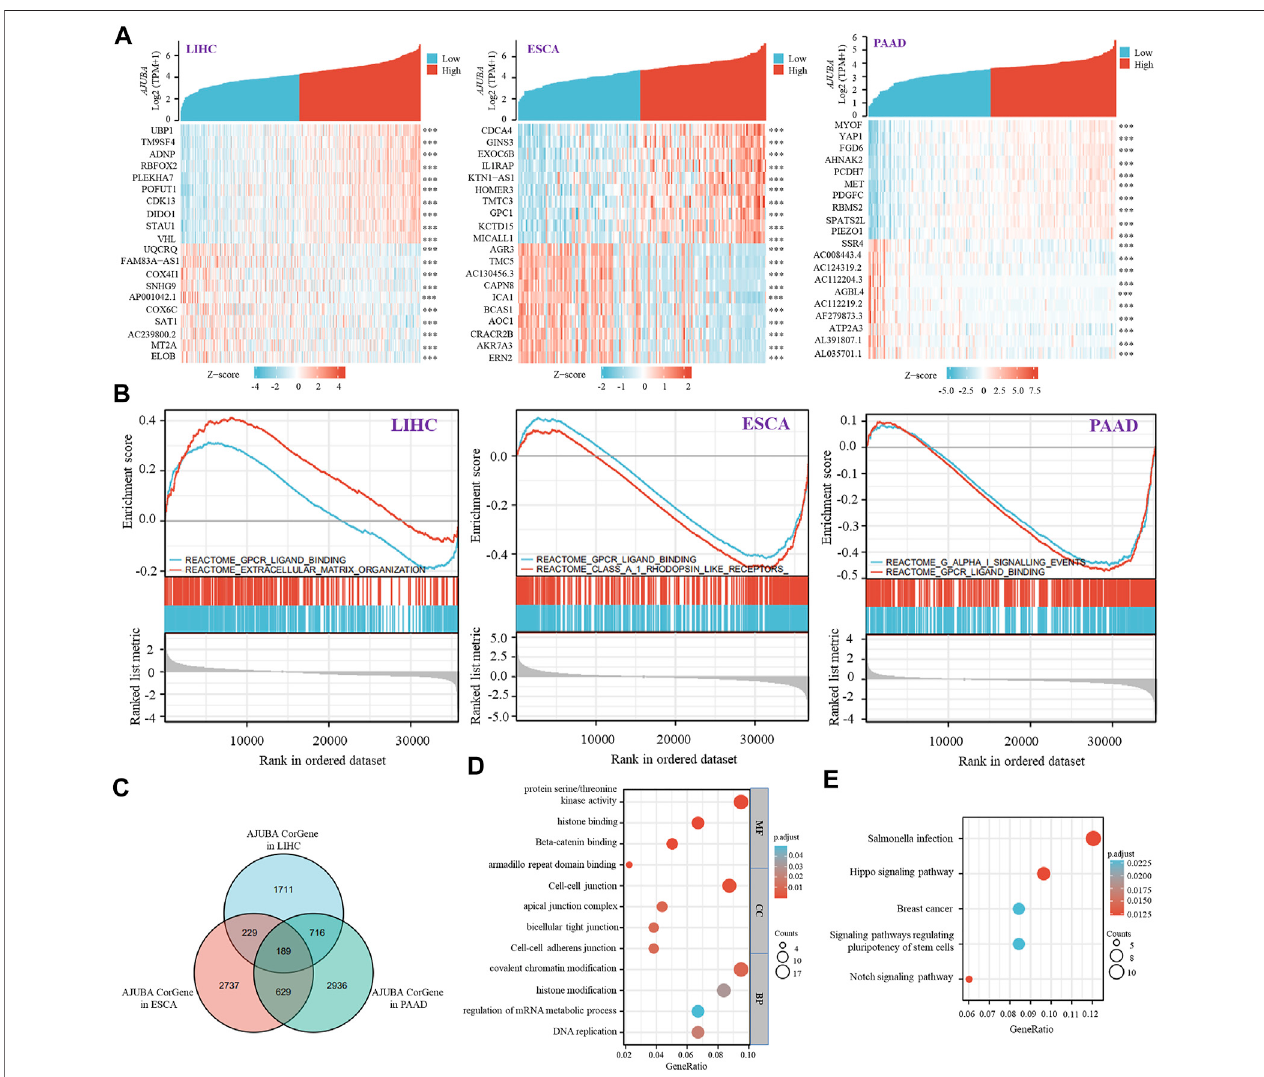
FIGURE8| AJUBA-relatedgeneenrichmentanalysis. (A) theheatmapshowsthetop10geneswithpositiveandnegativeco-expressionofAJUBAinLIHC,ESCA, and pancreatic adenocarcinoma (PAAD) via TCGA database. (B) gene set enrichment analysis (GSEA) was performed in LIHC, ESCA, and PAAD based on MSigDB collections. (C) intersection co-expression genes of AJUBA in LIHC, ESCA, and PAAD. Note: r > 0.4 or r < − 0.3 and p < 0.001. (D,E) based on the interacted genes of AJUBA in (C) , gene ontology (GO) analysis and Kyoto Encyclopedia of Genes and Genomes (KEGG) pathway analysis were performed.